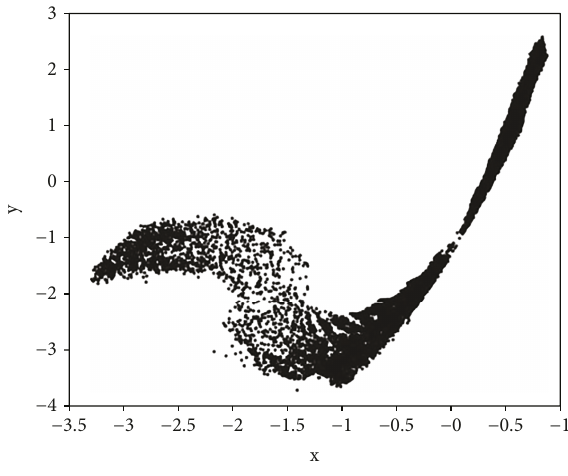
Figure 4: The chaotic attractor of ux plane.